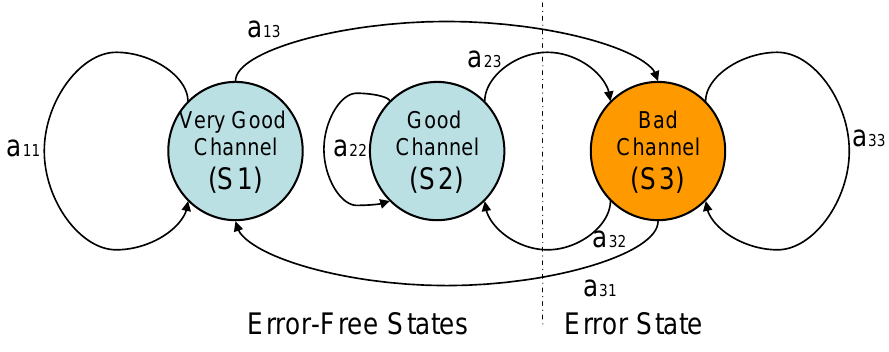
Figure 9. The three-state Fritchman model for dynamic HBC